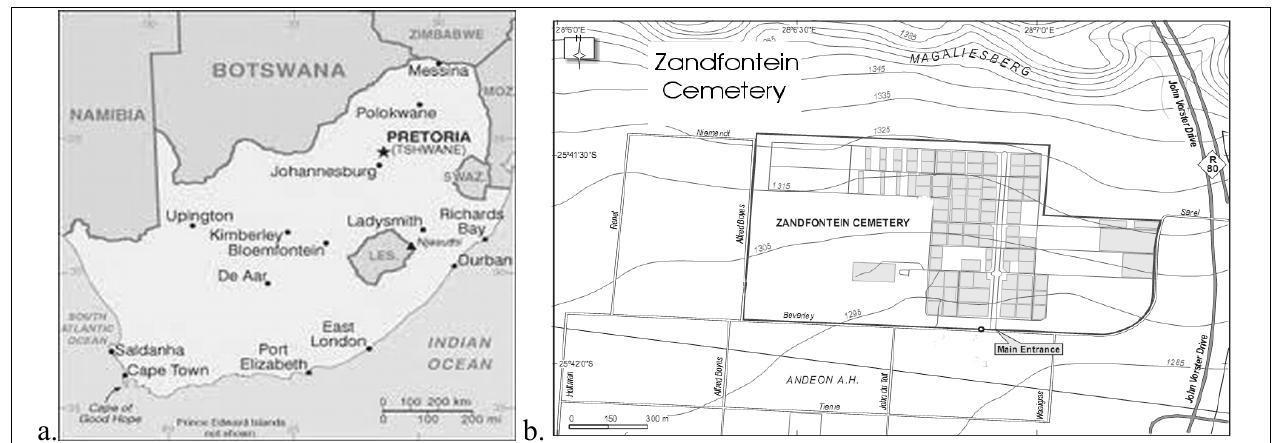
Figure 1. Location and map of study area.